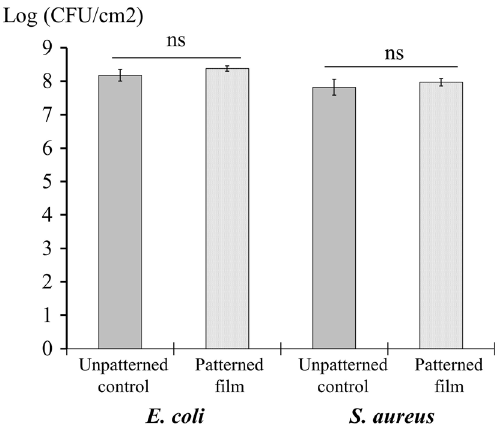
Figure 5. ISO 22196 standard. Antibacterial activity of a patterned film on E. coli and S. aureus according to the ISO 22196 standard. Bars represent average bacterial counts expressed as Log(CFU/cm 2 ). ns no significant.